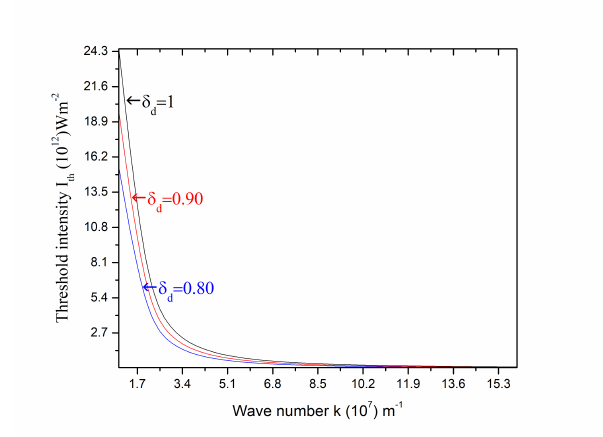
Fig. 1 Variation of threshold intensity I th Vs wave number k